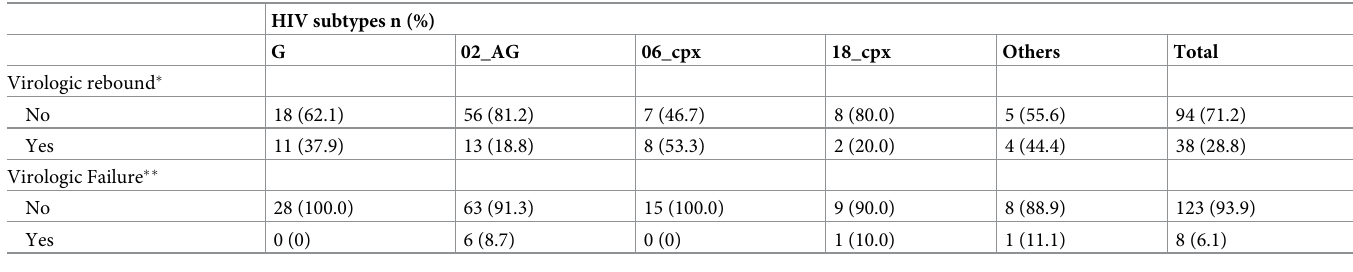
Table 5. Proportion with virologic rebound or virologic failure during the study period.